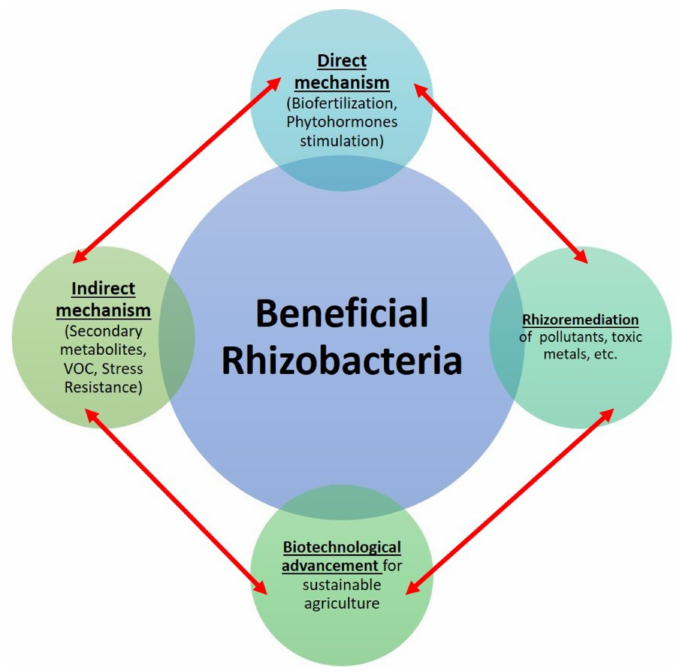
Figure 2. Exploration of the direct and indirect mode of action of beneficial rhizobacteria toward sustainable